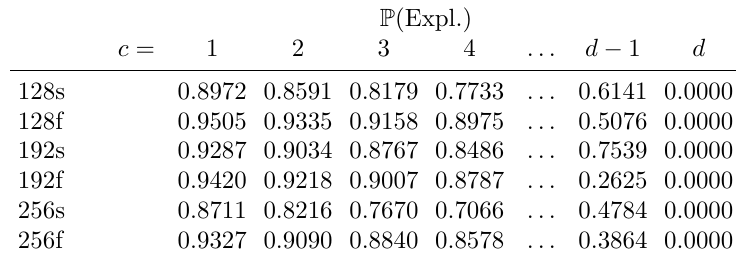
Table 9: Analysis of the layer caching countermeasure for all SPHINCS + parameter sets. P (Expl.)